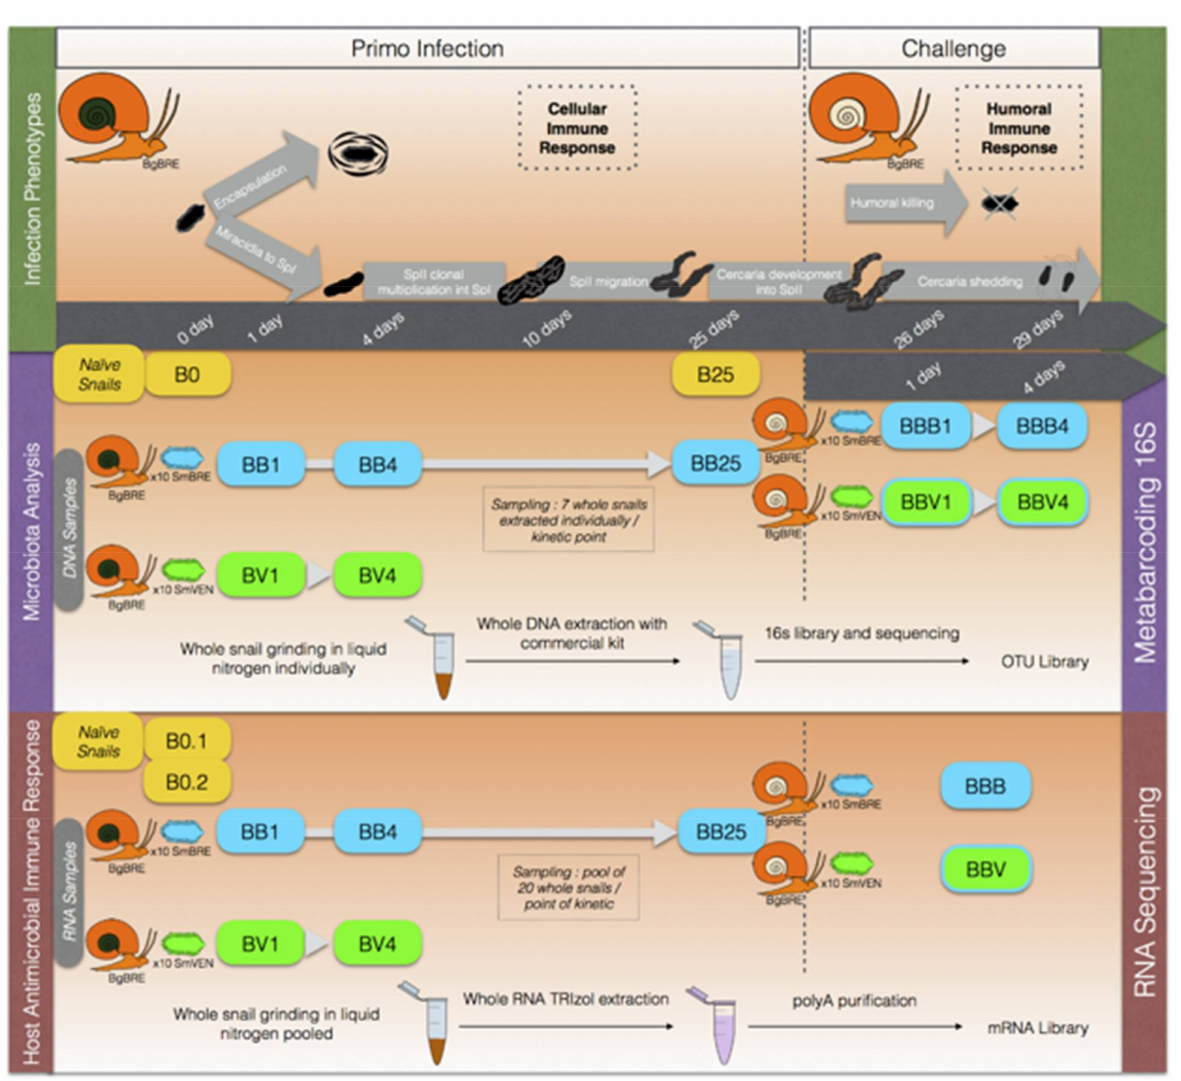
Figure 1. Experimental